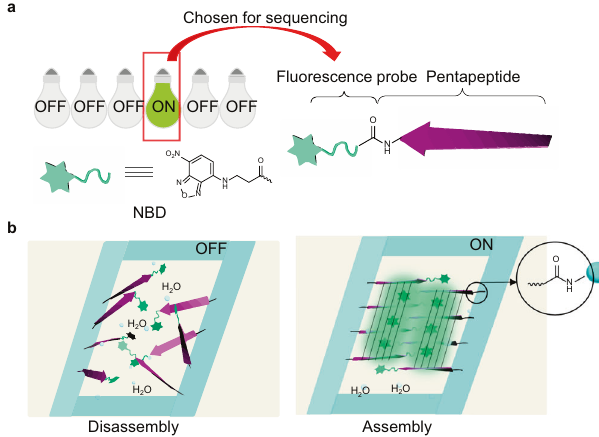
Fig. 1 The principle for screening self-assembling peptides based on OBOC combinatorial peptide library. a The screening process of self- assembling peptides by picking up the turn-on bead. The red line suggests the turn-on “ bead ” . b Self-assembling peptides form hydrophobic pockets for fl uorescent activation of N-terminally tethered organic dye nitro-1,2,3- benzoxadiazole (NBD). The blue band represents the bead matrix of crosslinked polystyrene. The black line indicates the linker